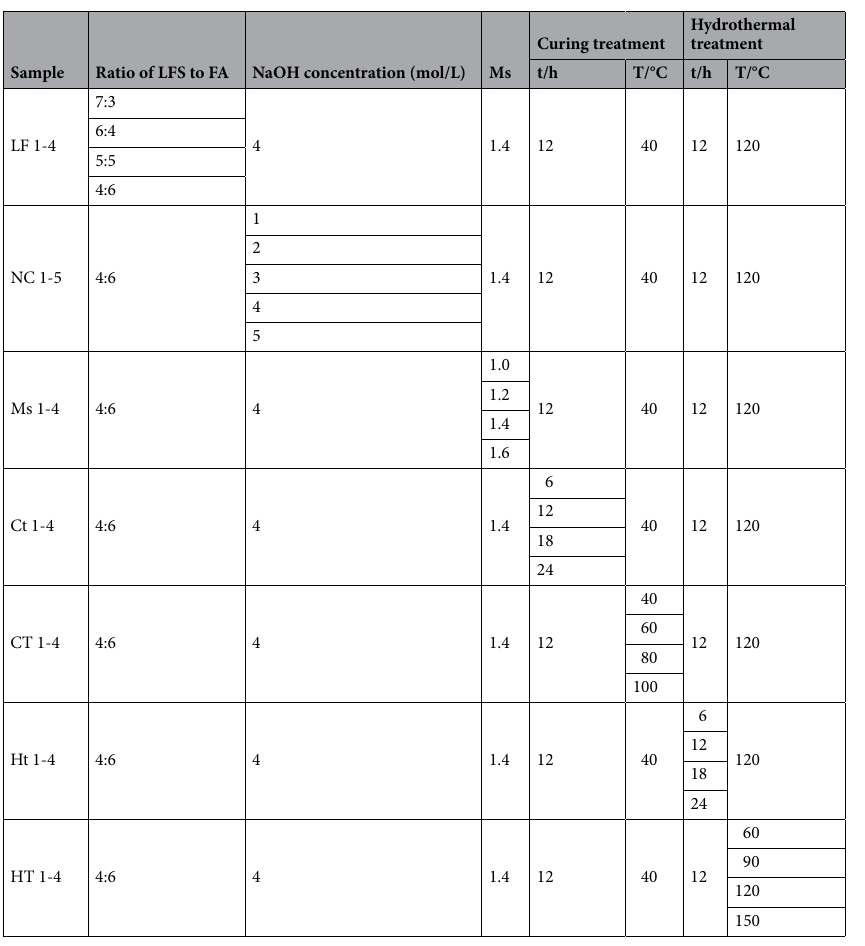
Table 2. Synthesis conditions for LFS and